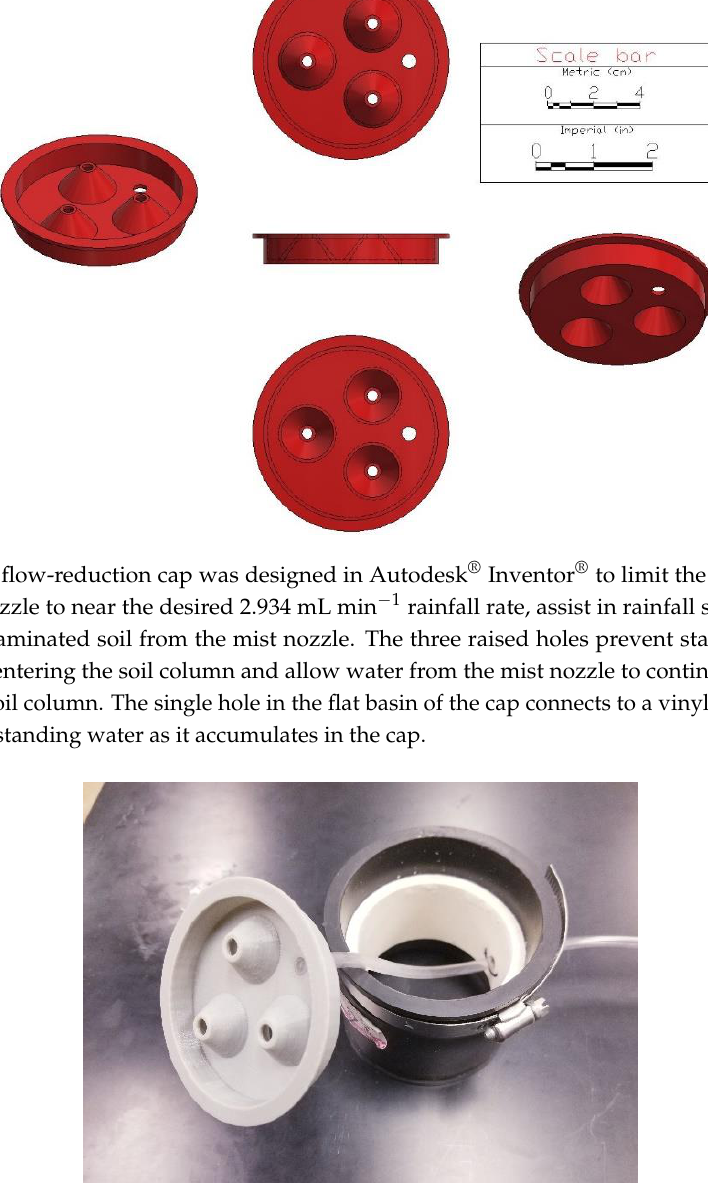
Figure 3. Flow-reduction cap housing. The flow-reduction cap housing consists of the coupling, coupling spacer, flow-reduction cap, and discharge tube. A bead of silicone caulk will be applied around the top of the coupling spacer that touches the lip of the flow-reduction cap. Table 1. The following is a complete parts list for the soil column portion of the complete soil column system, as shown in Figure 1b.